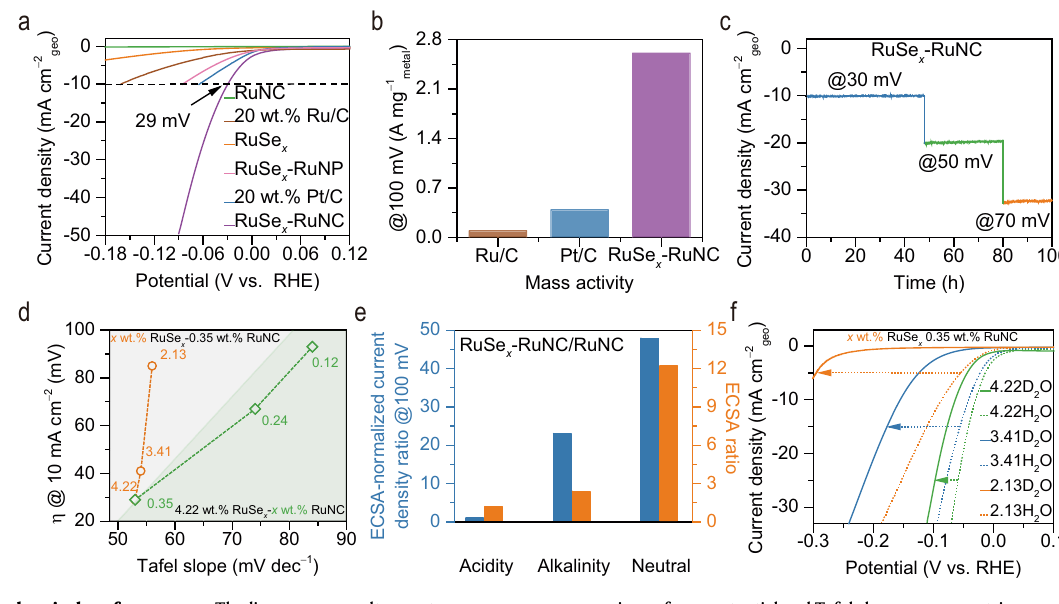
comparisonofoverpotentialandTafelslopepergeometricarea. e Thecomparison of ECSA and ECSA-normalized current density. f The kinetic isotope effect